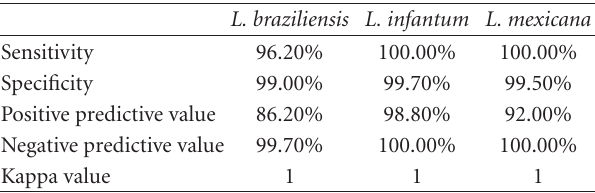
Table 6: Result of the indices that evaluate the reliability of the diagnostic test (ELISA) using the Fe-SODe fraction of the di ff erent strains of Leishmania in sera of dogs of the Yucatan Peninsula